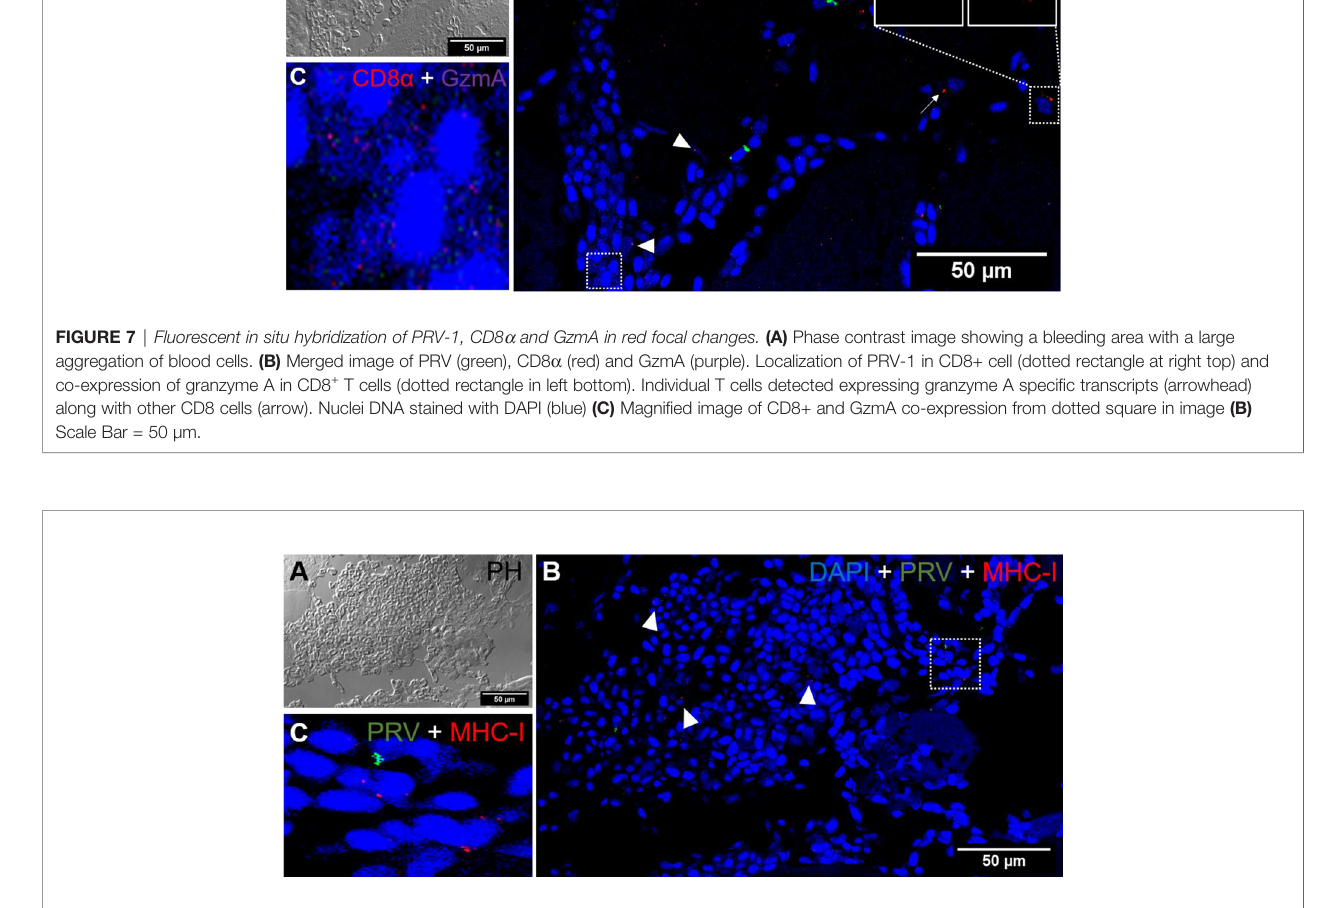
FIGURE 8 | Fluorescent in situ hybridization of PRV-1, and MHC-I in areas of red focal changes. (A) Phase contrast image showing a large hemorrhage. (B) Merged image of PRV-1 and MHC-I showed no co-expression of PRV-1 in MHC-I cells, but a few cells were detected in the bleeding area (arrowhead). (C) Magni fi ed image from image B (dotted rectangle) showing PRV-1 infected cells along with MHC-I cells. Scale Bar = 50 µm.